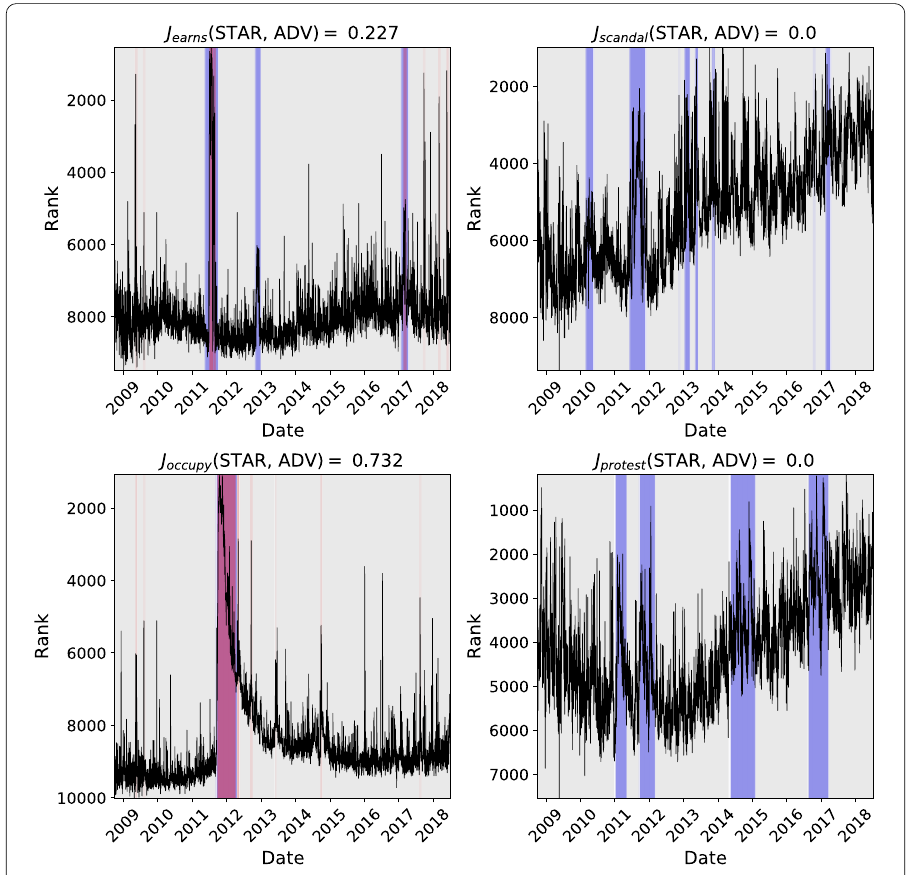
Figure 17 Occupy Wall Street. Comparison of STAR and ADV indicator windows for some words surrounding the “Occupy Wall Street” movement during